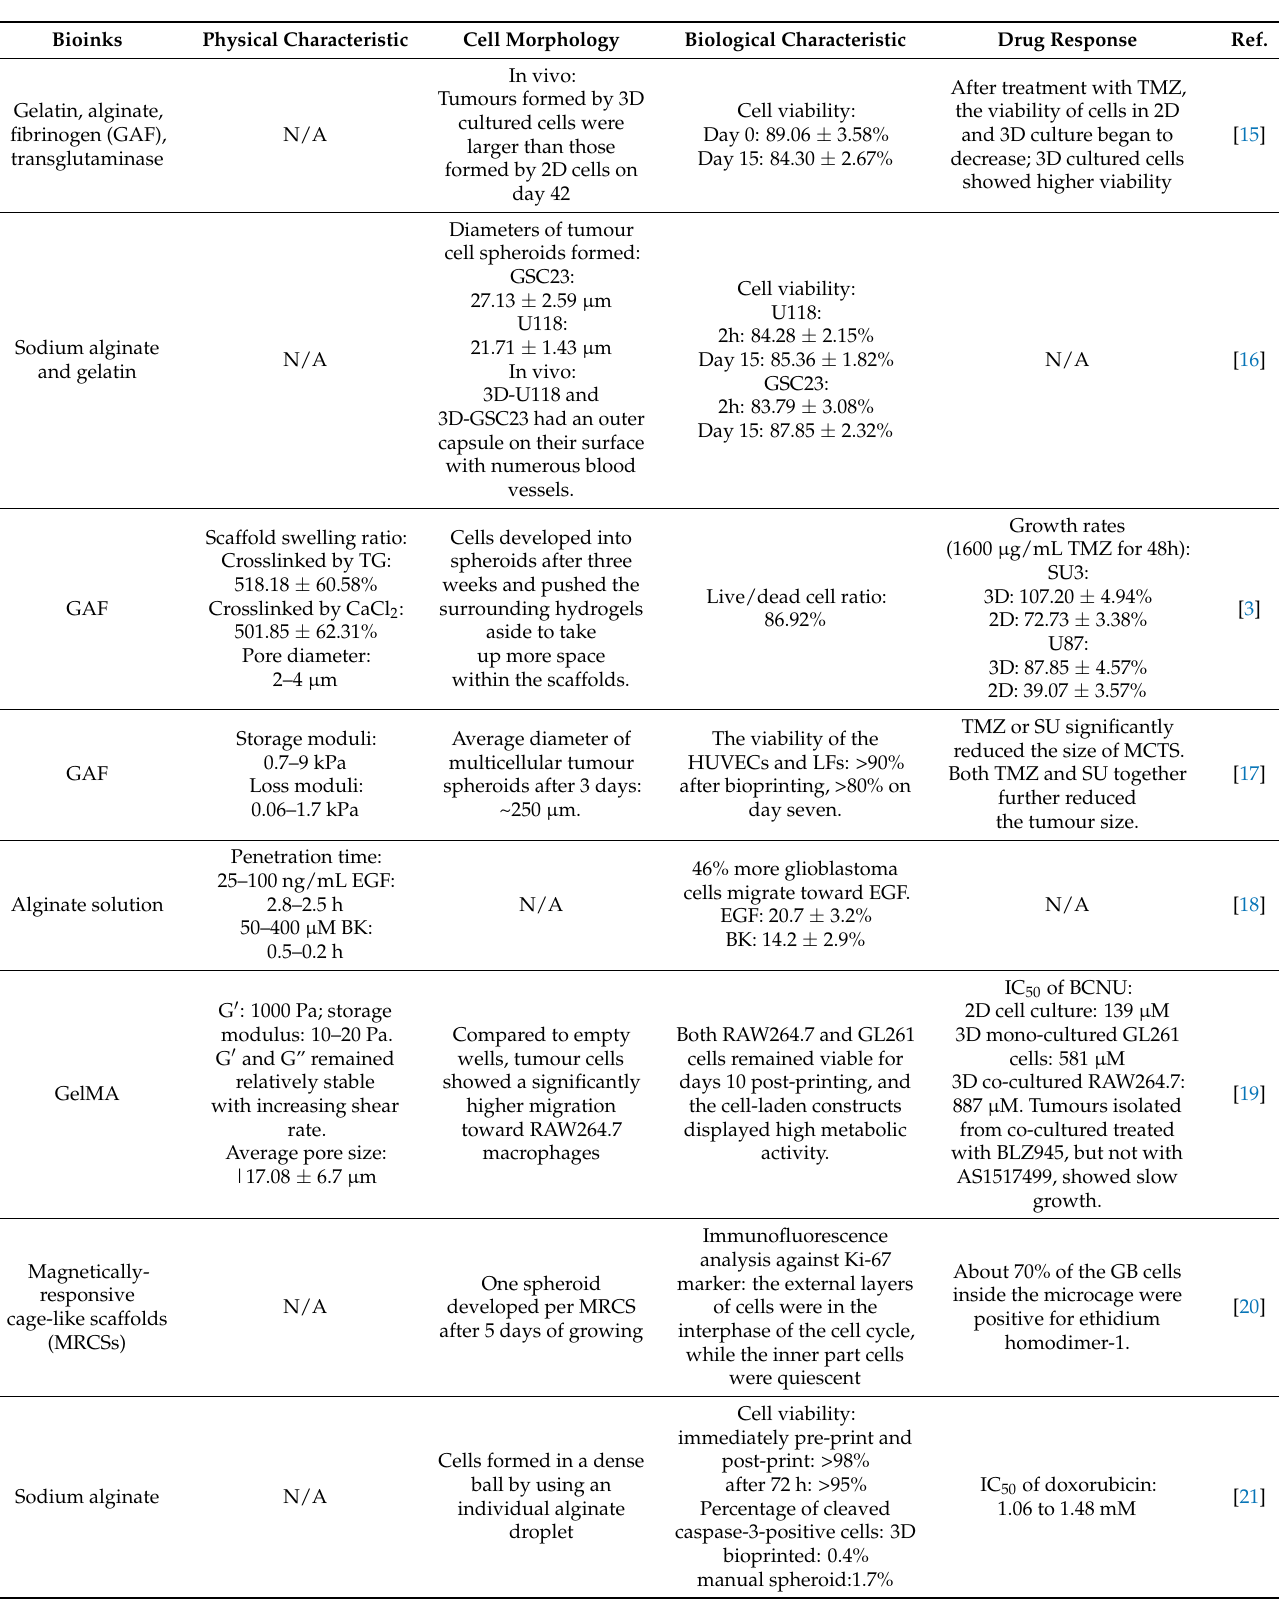
Table 3. Bioink properties and the experimental outcomes of the studies included ( n =